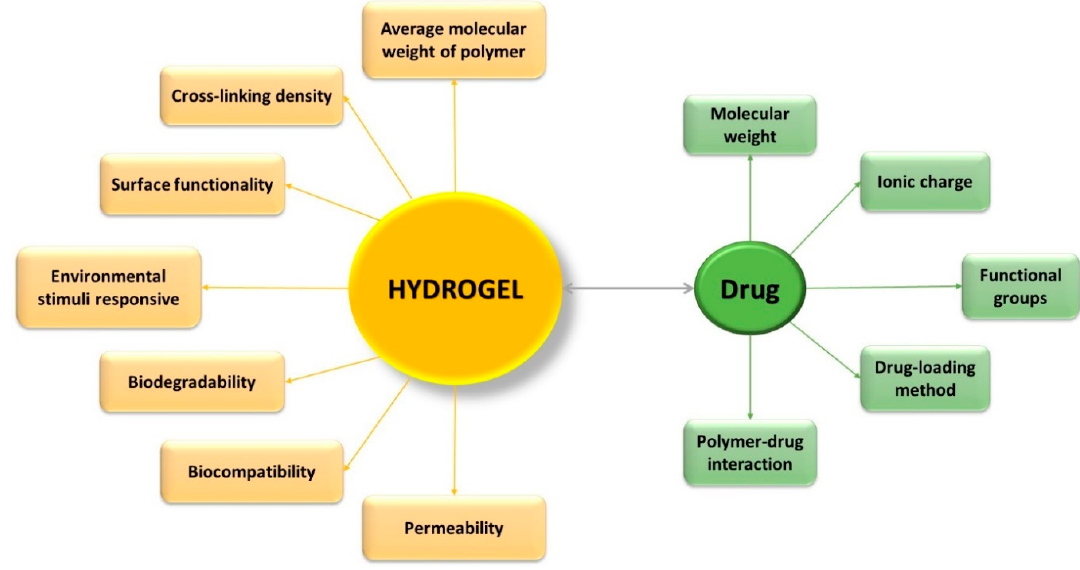
Figure 1. Characteristics which influence the effectiveness of controlled drug-delivery process.